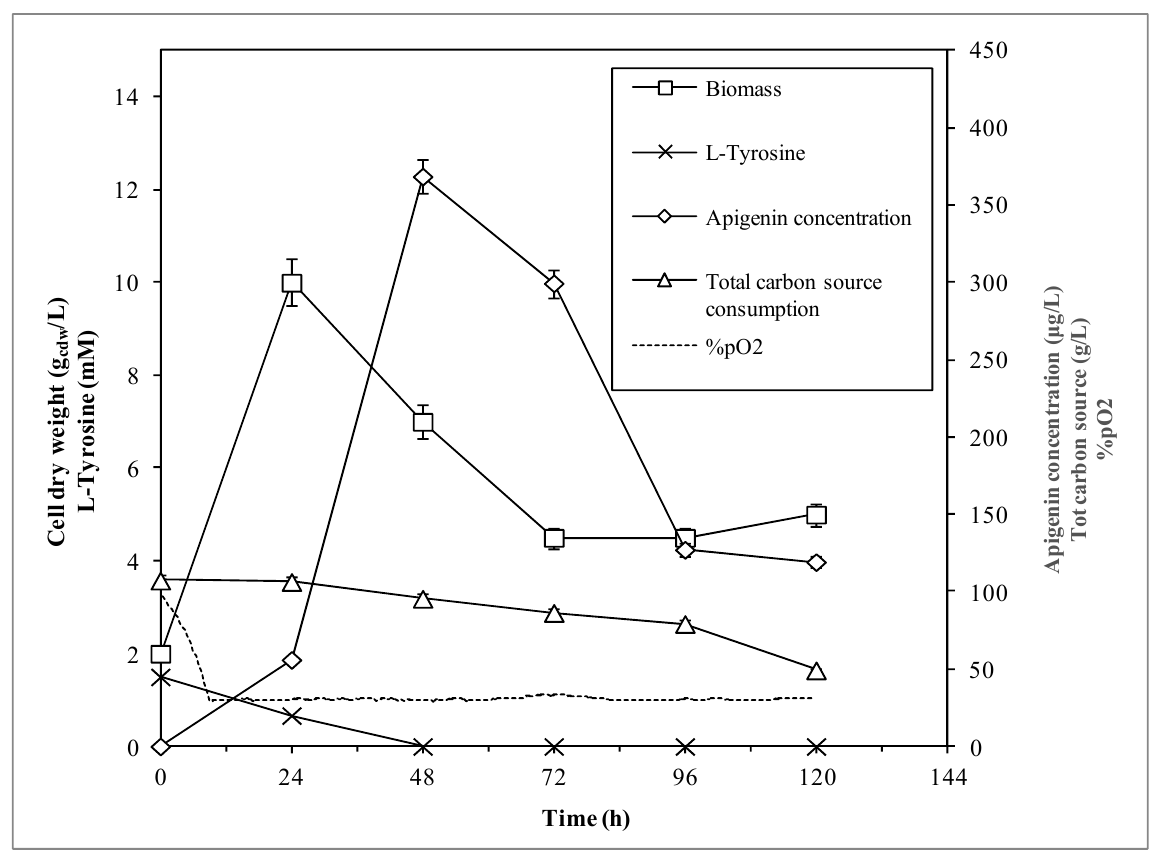
Figure 6. Batch experiments of Streptomyces albus -pAPI with the addition of 1.5 mM L-tyrosine: kinetics of growth and apigenin concentration, total carbon source and L-tyrosine consumption and % pO 2 profile.